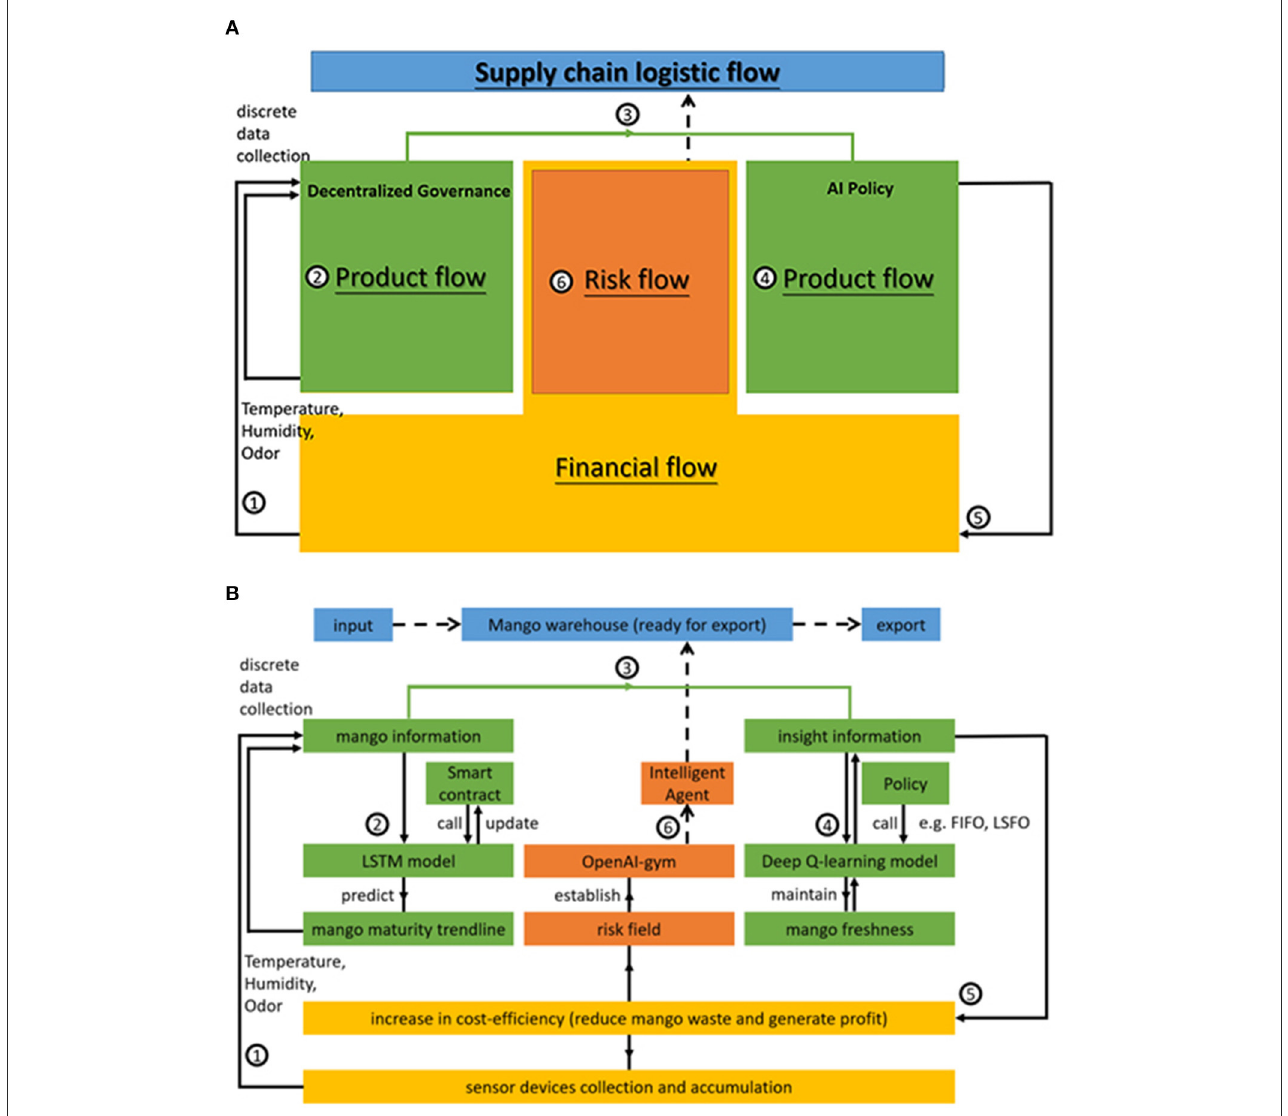
FIGURE1 (A) Double-helix architecture based on AWF structure. (B) Double-helix architecture based on AWF